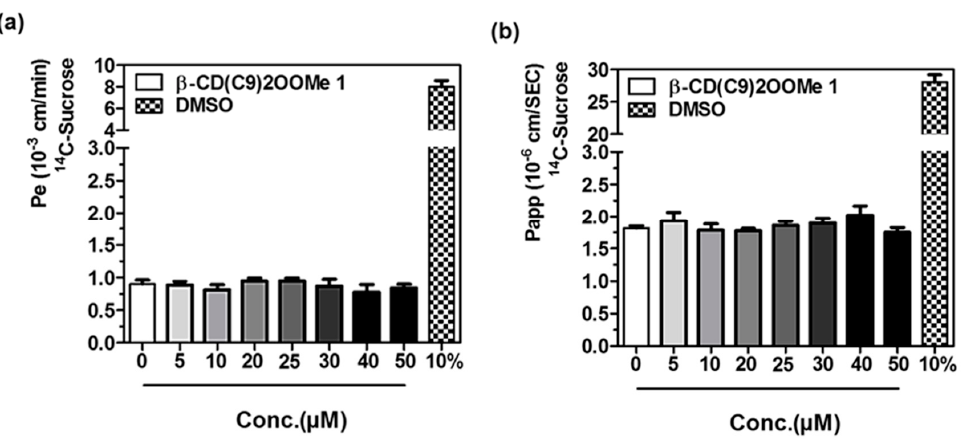
Figure 6. 14 C-Sucrose permeability (Pe) and apparent permeability (Papp) assessment in two in vitro models treated with different concentrations of 1 . DMSO 10% was used as the positive control of biological barrier disruptions. Bars represent the mean of six filters + standard error of the mean. ( a ) represents the Pe of 14 C-Sucrose in the brain-like endothelial cells (BLECs) model and ( b ) represents the Papp of 14 C-sucrose in the intestinal Caco-2 model.